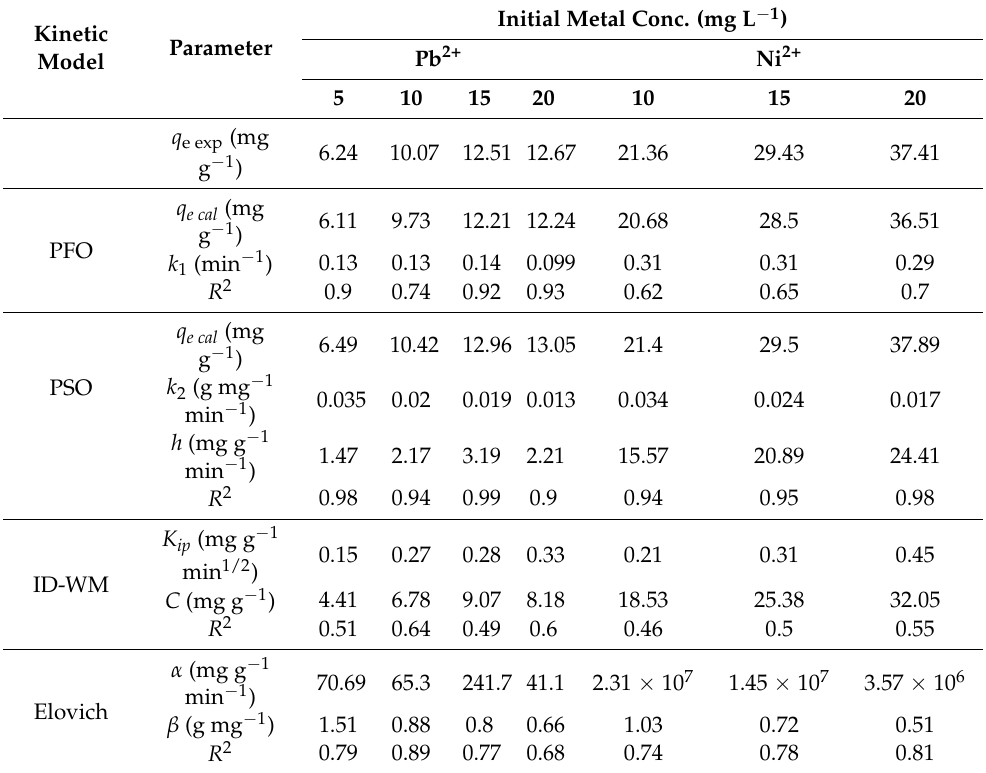
Table 1. Parameters of the nonlinear pseudo-first-order (PFO), pseudo-second-order (PSO), intra- particle diffusion of Weber and Morris (ID-WM), and Elovich kinetics models for the adsorption of Pb 2+ and Ni 2+ onto PANmod (Contact time = 0–300 min, PANmod dose = 0.5 g, pH = 5 ± 0.2 and 7 ± 0.2 for Pb 2+ and Ni 2+ ,